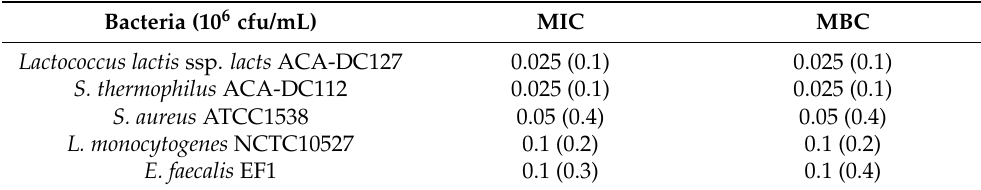
Table 4. Minimum inhibitory concentrations (MIC) and minimum bactericidal concentrations (MBC) of TO@NZ hybrid nanostructure against lactic acid bacteria and pathogens (% w / v